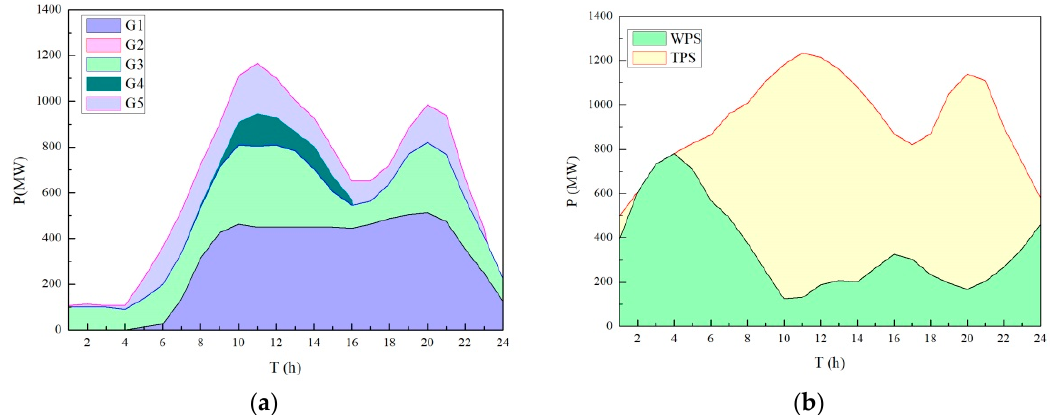
Figure 7. Output State of Each Thermoelectric Unit and Load Supply within the Park in Scenario 2. ( a ) Output State of Each Thermoelectric Unit in Scenario 2; ( b ) Load Supply Within the Park in Scenario 2.